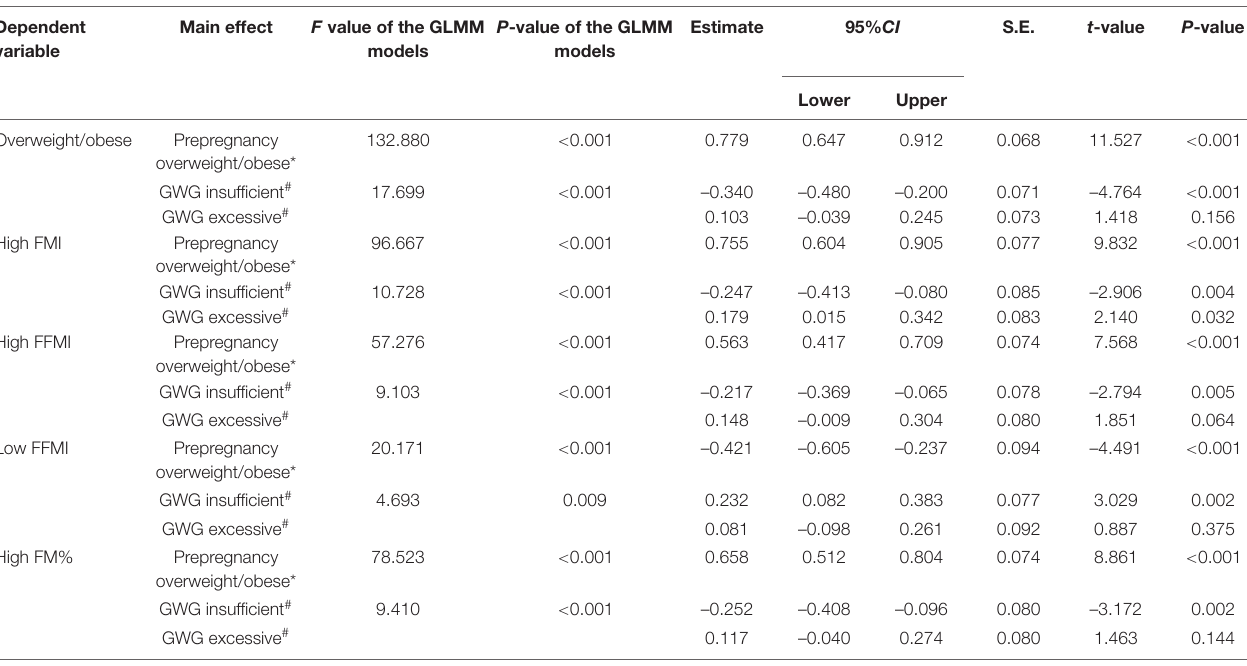
TABLE 4 | Generalized Linear Mixed Models (GLMMs) associations between prepregnancy weight status, GWG groups and the adiposity indicators in kindergarten